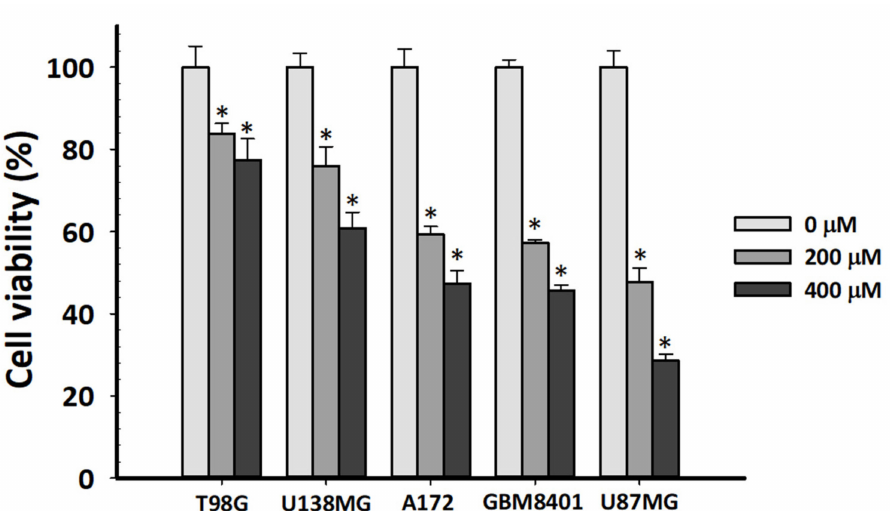
Figure 1. Response of glioblastoma cell lines to chemotherapy drug temozolomide (TMZ). We performed 3-(4,5-dimethylthiazol-2-yl)-2,5-diphenyltetrazolium bromide (MTT) assays on T98G, U138MG, A172, GBM8401 and U87MG cell lines after 72 h of nontreatment or 200 or 400 µ M of TMZ treatment. Values are expressed as mean ± standard deviation (SD; n = 4). * p < 0.05 relative to